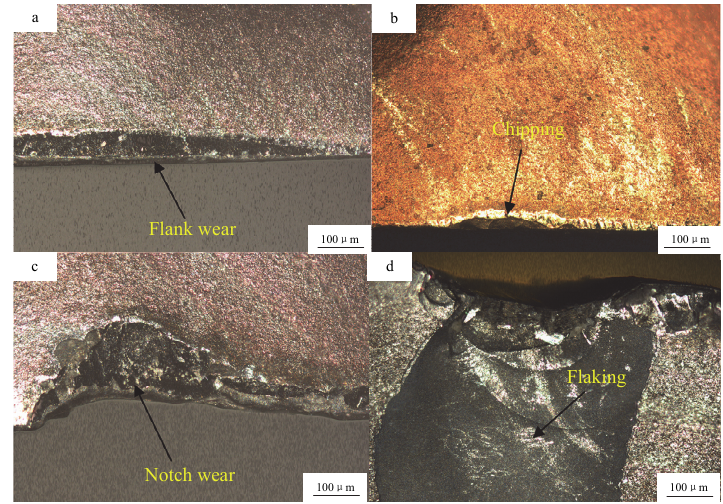
Figure 6. Several wear problems occurred in the milling of Inconel 718 with carbide ball nose cut ‐ ters: ( a ) flank wear; ( b ) chipping; ( c ) notch wear; ( d ) flaking [30]. ( a ) flank wear; ( b ) chipping; ( c ) notch wear; ( d ) flaking